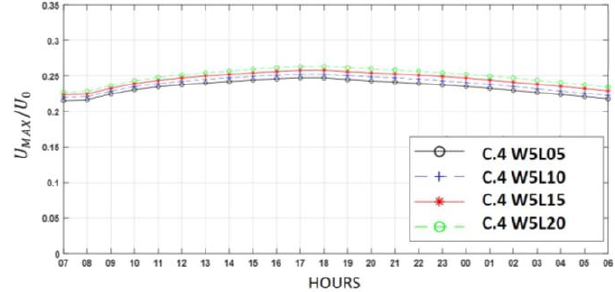
Fig. 5. Maximum nondimensional velocity U MAX /U 0 in the internal court of courtyard 4 versus time (hours of the day),